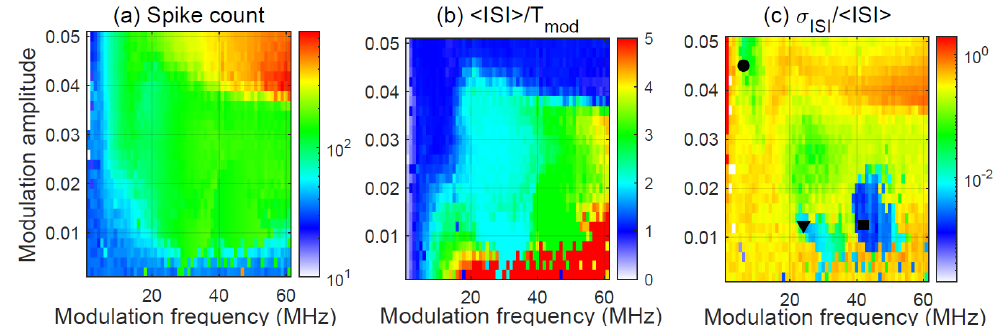
Figure 1. ( a ) Number of spikes in the intensity time series, in logarithmic color code, as a function of the modulation amplitude and frequency. ( b ) Mean inter − spike − interval, normalized to the period of the modulation. Here, the color scale is saturated such that red represents (cid:104) ISI (cid:105) / T mod ≥ 5. ( c ) Standard deviation of the ISI distribution normalized to the mean ISI. Note the logarithmic color scale. The symbols indicate the parameters used in Figure 2.